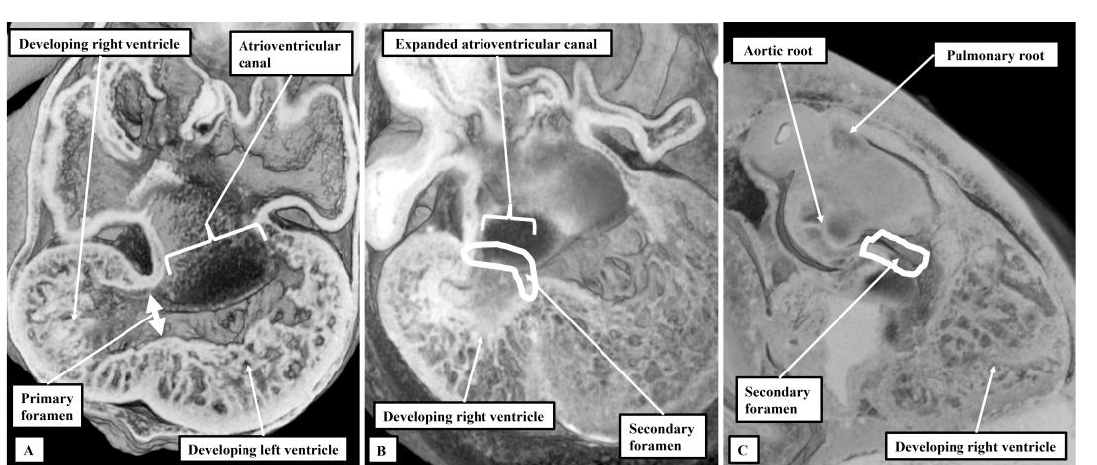
Figure 1. The images show the initial stages of formation of the ventricles in the human heart. Panel ( A ) shows a “four chamber” section at Carnegie stage 14, during the fifth week of development. The atrioventricular canal is supported exclusively by the developing left ventricle. Later in the fifth week, at Carnegie stage 15, as shown in panel ( B ), another four chamber section, the atrioventricular canal expanded to bring the cavity of the right atrium into communication with the developing right ventricle. This resulted in remodeling of the primary interventricular communication. As is shown in panel ( C ), also at Carnegie stage 15, but now showing the septal surface of the right ventricle, the secondary interventricular communication now provides the outlet for the developing left ventricle.